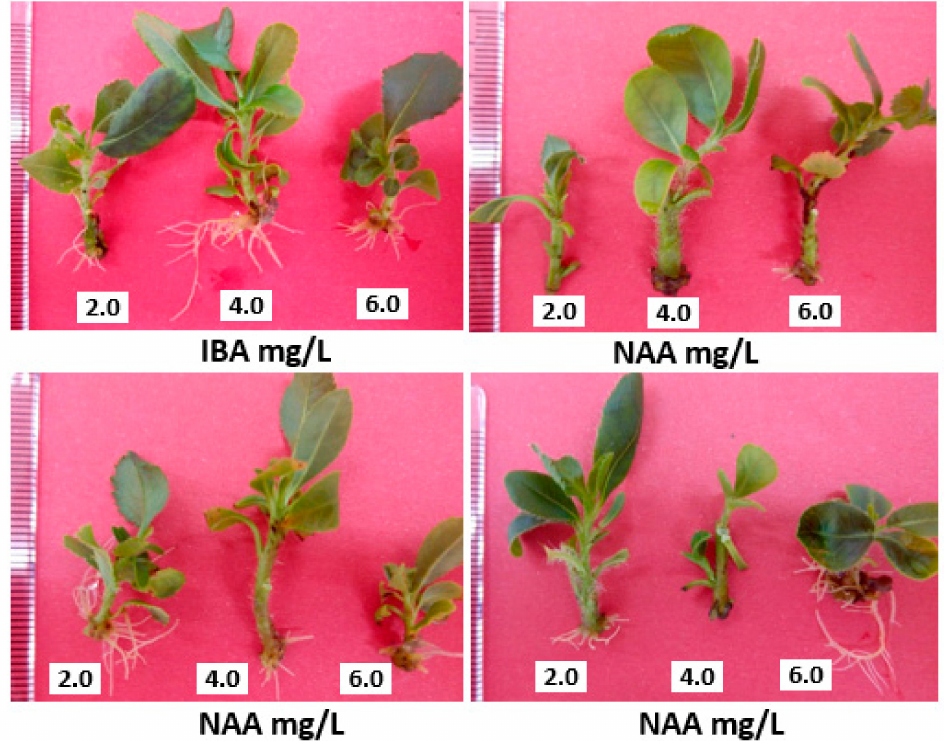
Figure 6. Root formation in YV2 and YV4